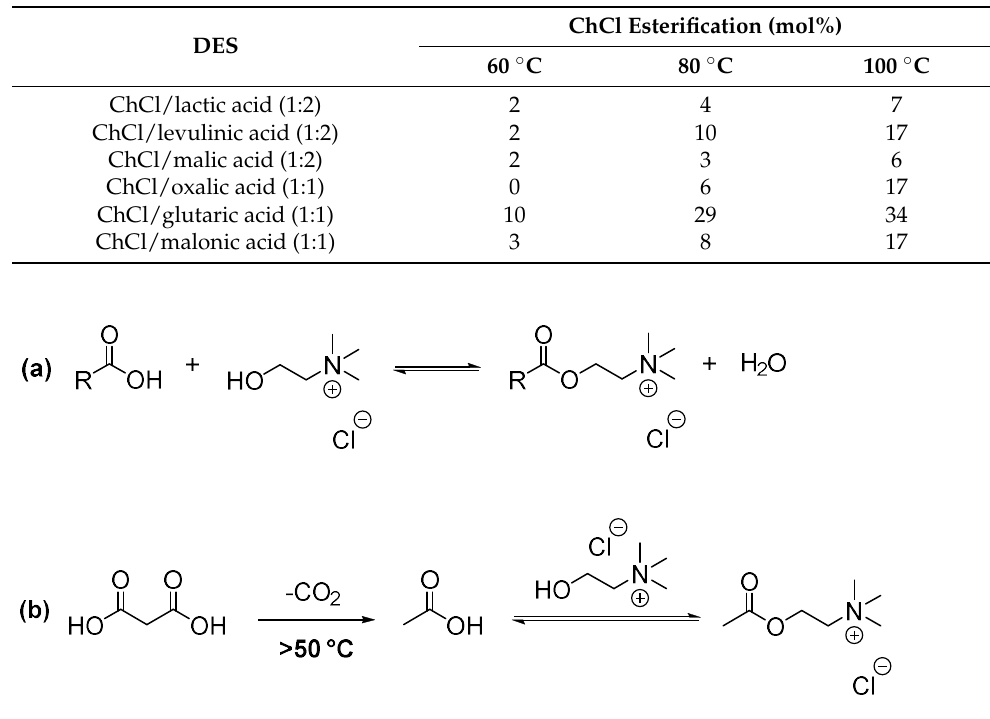
Scheme 1. Esterification reaction between the ChCl and the acid component in the DES ( a ) and parallel degradation pathway of MA in ChCl/MA ( b